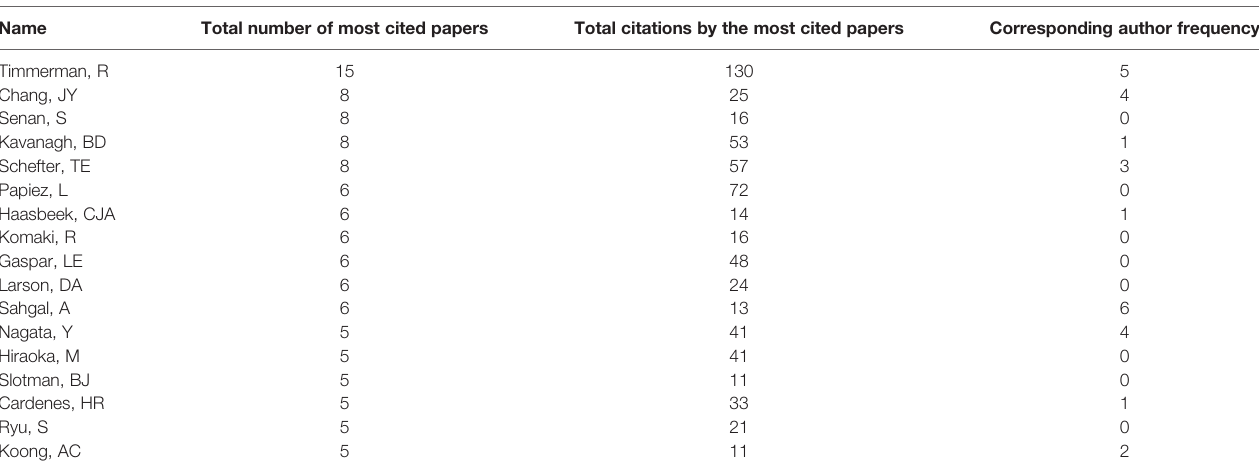
TABLE 2 | Authors of at least fi ve of the 100 most cited papers in SBRT until 2021.